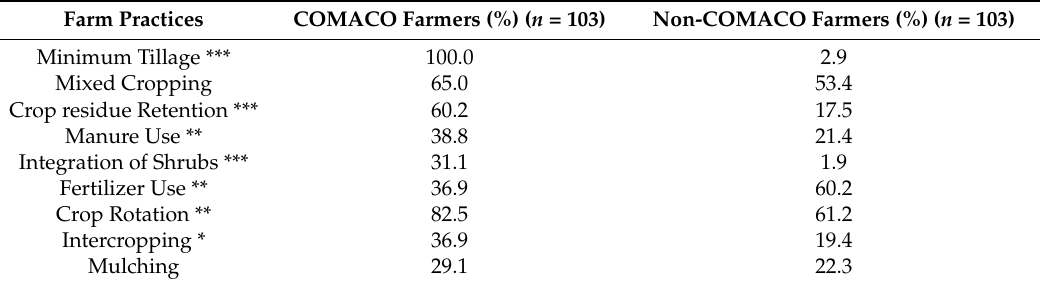
Table 1. Differences in Level of Adoption of Sustainable Farming